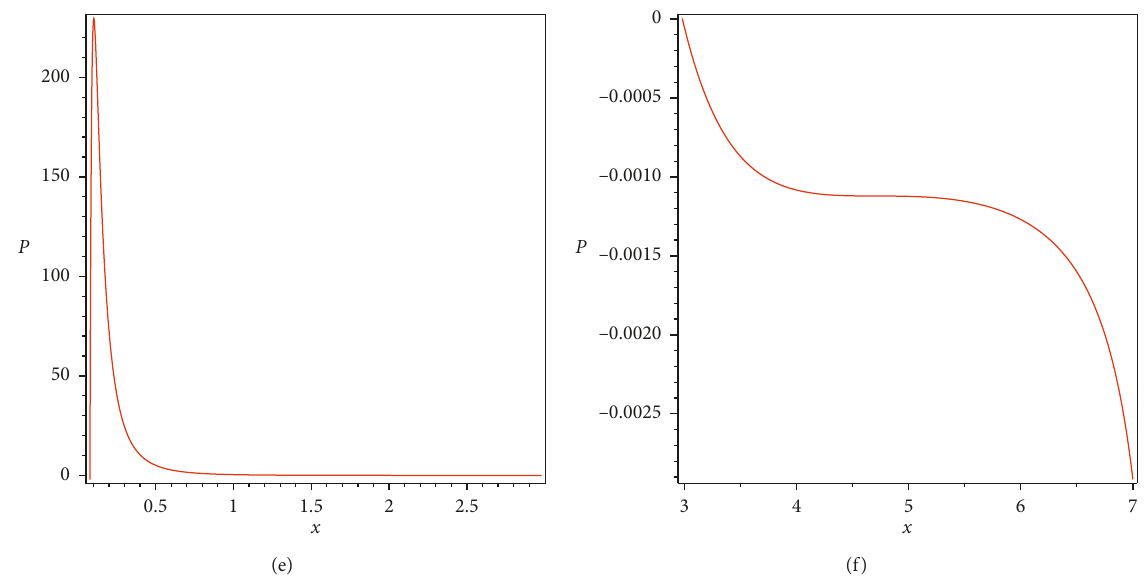
Figure 1: (a–c) Bifurcation diagram of nutrient in model (1) with respect to x . (d–f) Bifurcation diagram of phytoplankton in model (1) with respect to x . (a) and (d) for x ∈ ( 0 . 01 , 0 . 07807216867 ) . (b) and (e) for x ∈ ( 0 . 07807216867 , 2 . 981219088 ) . (c) and (f) for x ∈ ( 2 . 981219088 , 7 )